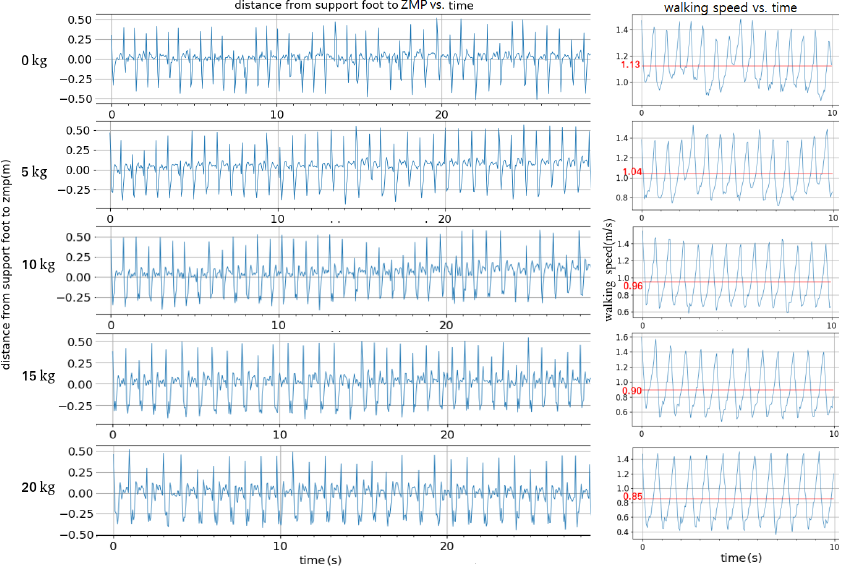
Figure 20. Effect on ZMP and walking speed from adding mass to the legs vs.